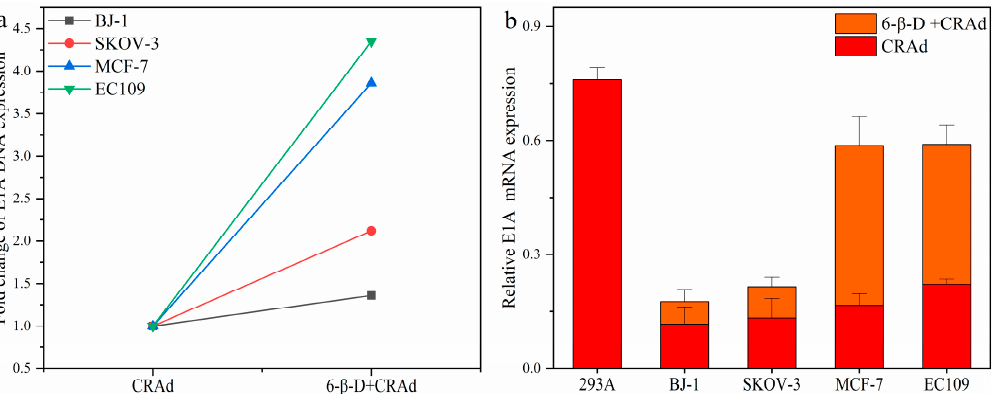
Figure 4. Combination of 6- β -D with CRAd increased viral replication in various cancer cell lines. ( a ) 6- β -D promoted CRAds invasion into cancer cells; ( b ) As detected by Real time-PCR, 6- β -D increased CRAd–E1A mRNA expression in cancer cells.